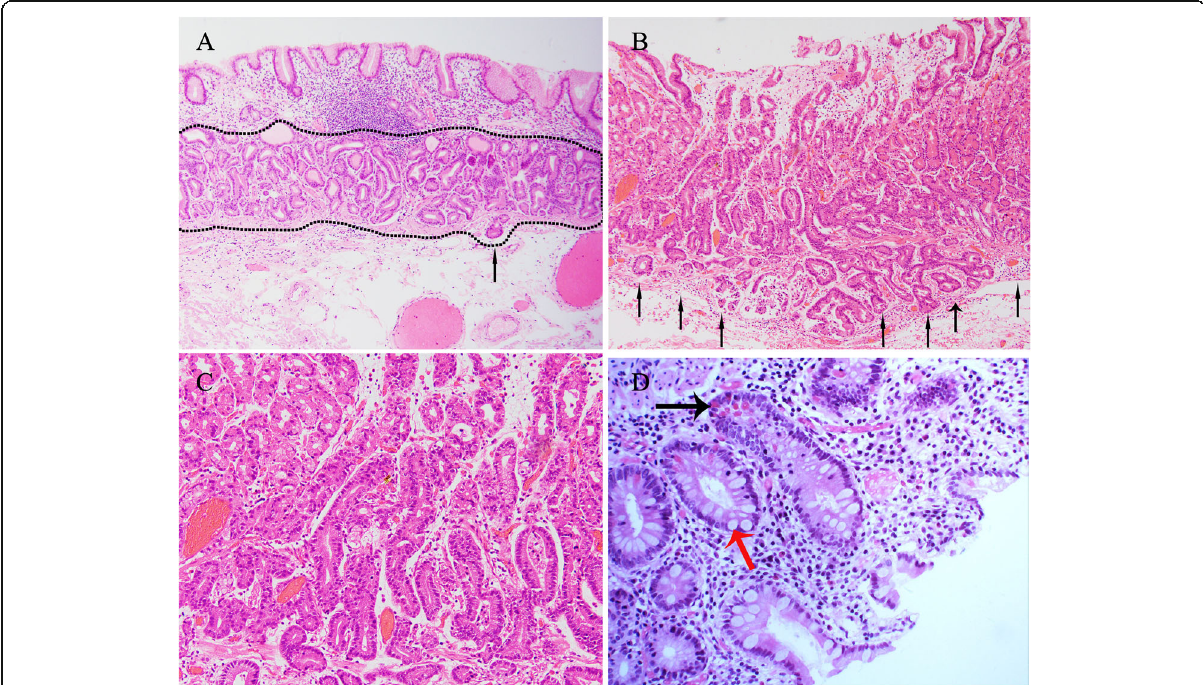
Fig. 3 a Low-power view, the tumor arose from the deep layer of the lamina propria mucosa (black line) and slightly invaded the submucosal layer (black arrow), the tumor surface was covered with normal foveolar epithelium (100×). b Tumor cells consisted of irregular anastomosing cords and cribriform glands that are similar to the fundic glands with invasion into the submucosal layer (arrow) (100×). c The complex glandular architecture seen at higher magnification producing anastomosing and so-called “ endless glands ” pattern, the tumor cells were mild atypia (200×). d Intestinal metaplasia had been seen in the background, in which we can see goblet cells (red arrow) and Pan ’ s cells (black arrow) (case 5)